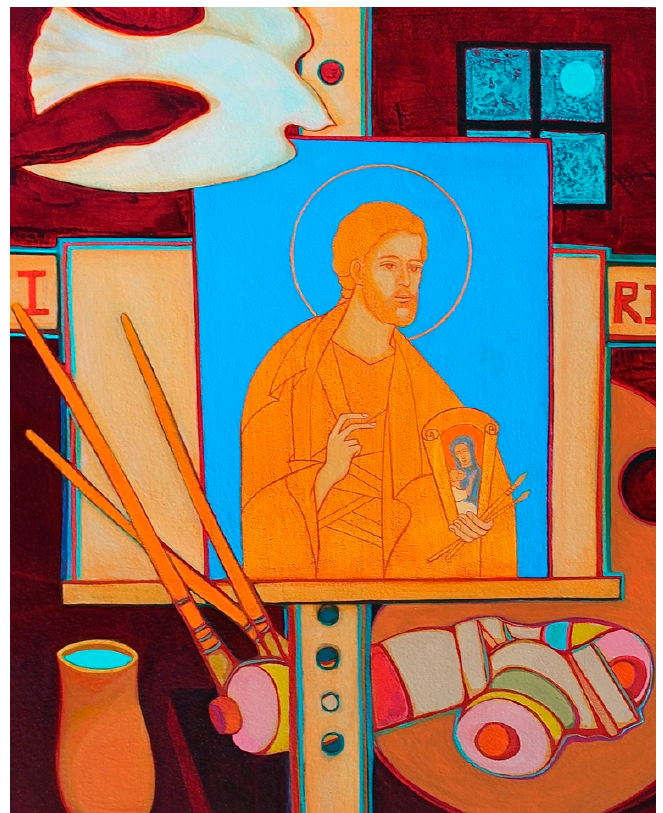
Figure 2. The Studio.